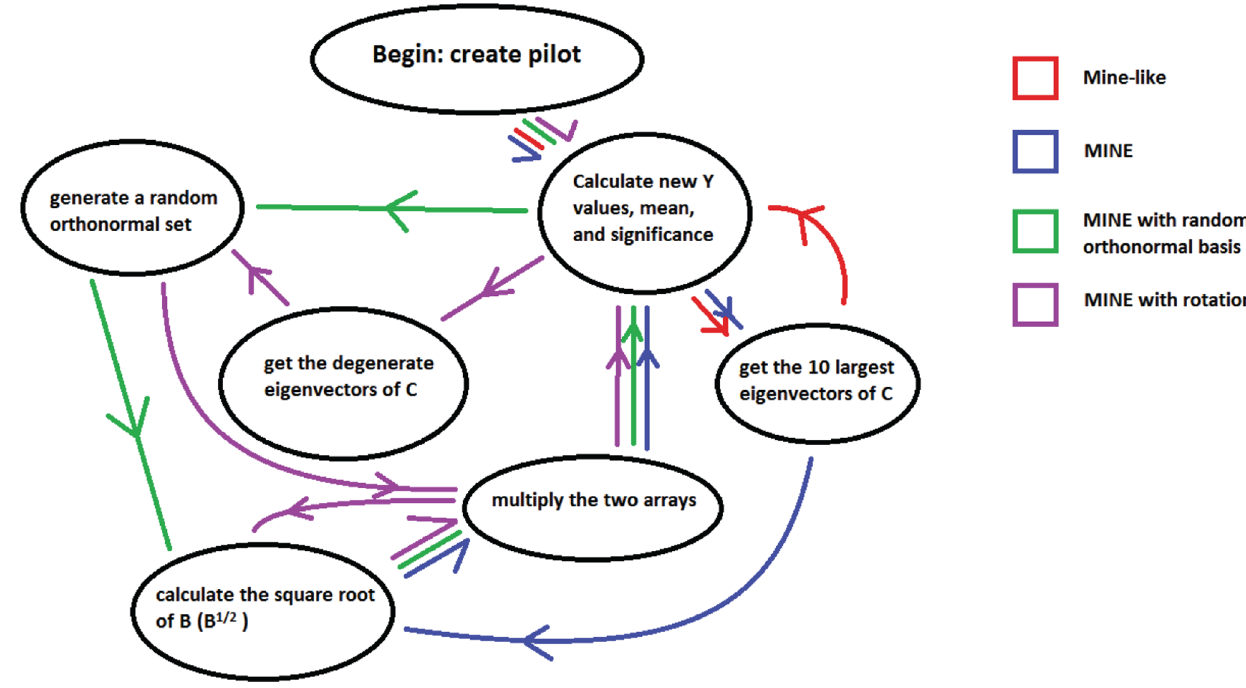
Figure 2. Visual representation of the pathways for each MINE method.